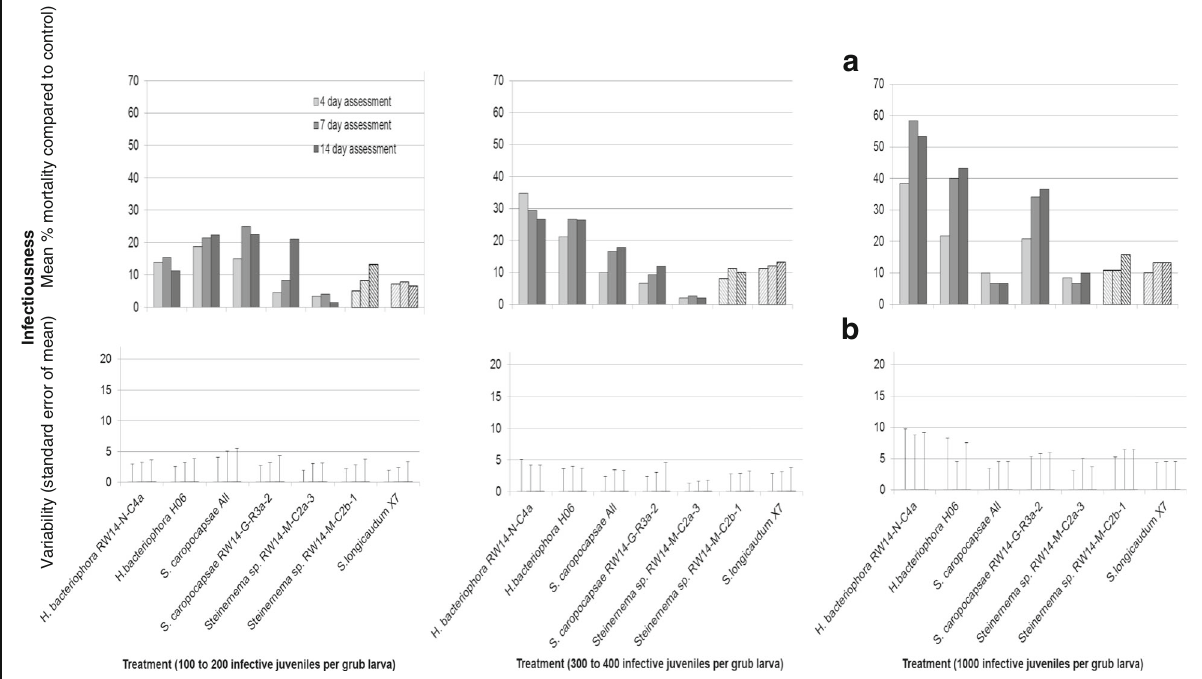
Fig. 1 Assessing which exposure period of Anomala graueri grubs to entomopathogenic nematodes leads to most distinct differences between treatments in laboratory bioassays. Mean value and variability separately presented to better assess ( a ) differences between percent-corrected mortality compared to control (mortality in EPN treatments minus natural mortality in untreated controls), and ( b ) smallest data variability. n = 6 to 15 grubs assessed per EPN species/strain and per concentration in single-grub arenas with